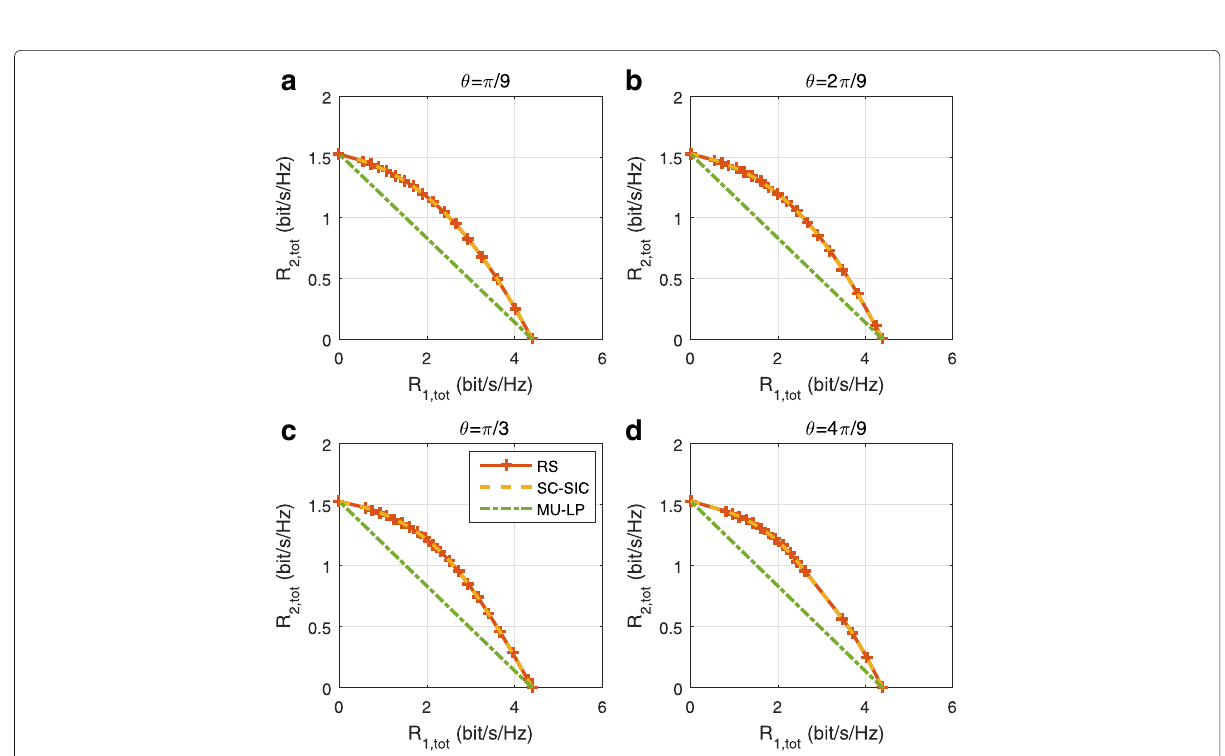
Fig. 30 Average rate region comparison of different strategies in imperfect CSIT, γ = 0.3, N t = 2, SNR = 10 dB. a θ = π/ 9. b θ = 2 π/ 9. c θ = π/ 3. d θ = 4 π/